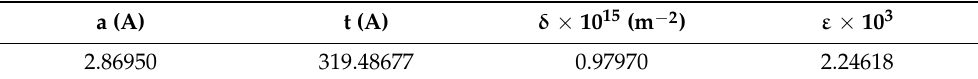
Table 3. Parameters obtained from the refinement of the XRD analysis in the sample AR.